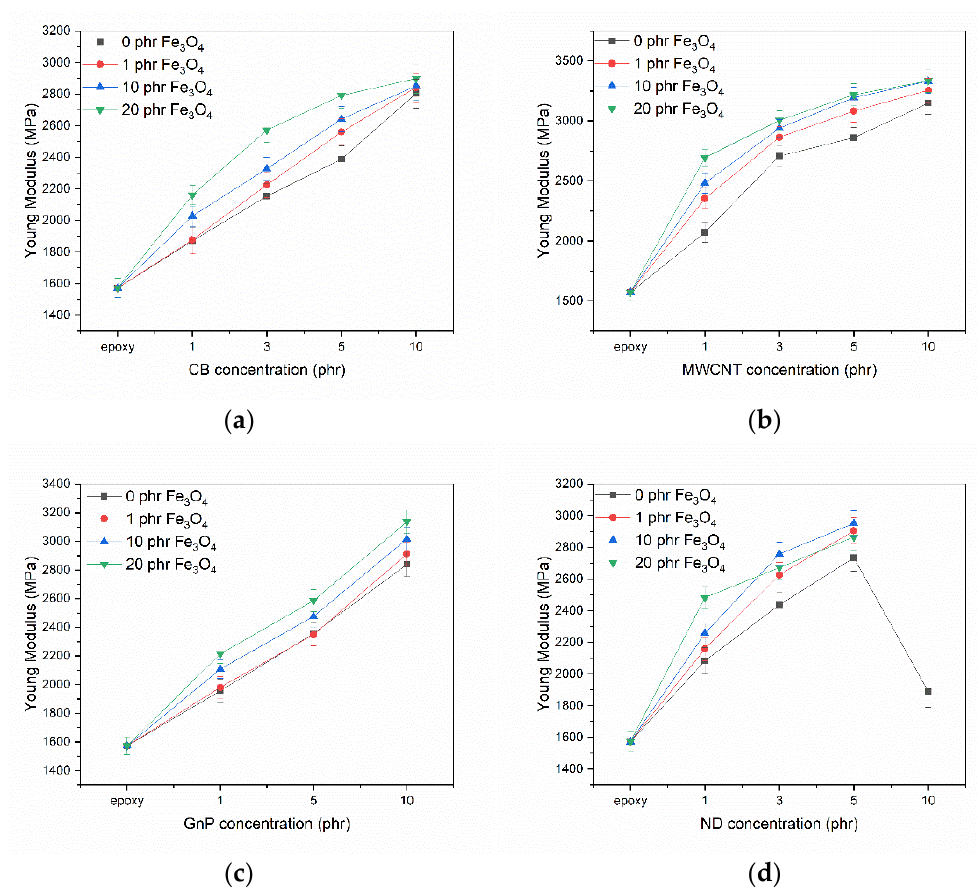
Figure 5. Young’s modulus as a function of ( a ) CB; ( b ) MWCNT; ( c ) GnP; ( d ) ND concentration for all examined systems.